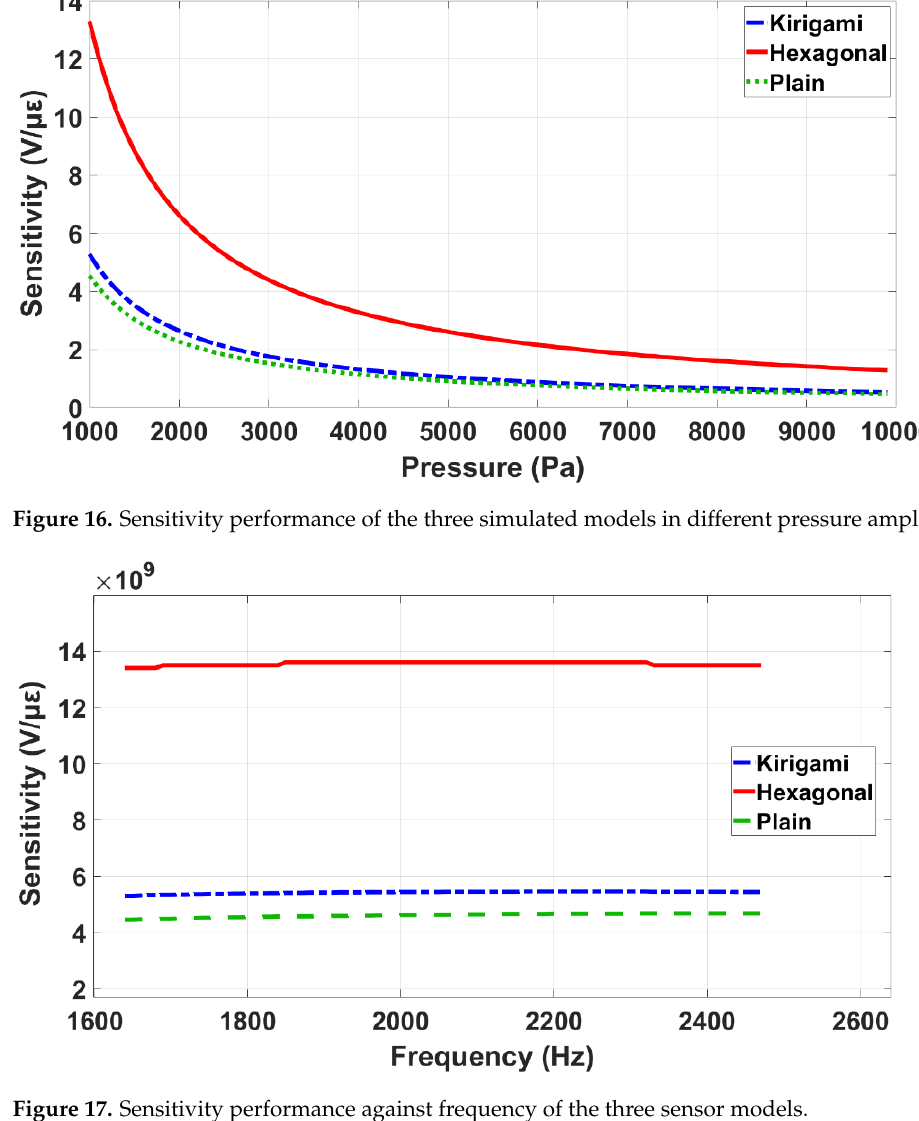
Figure 16. Sensitivity performance of the three simulated models in different pressure amplitudes.